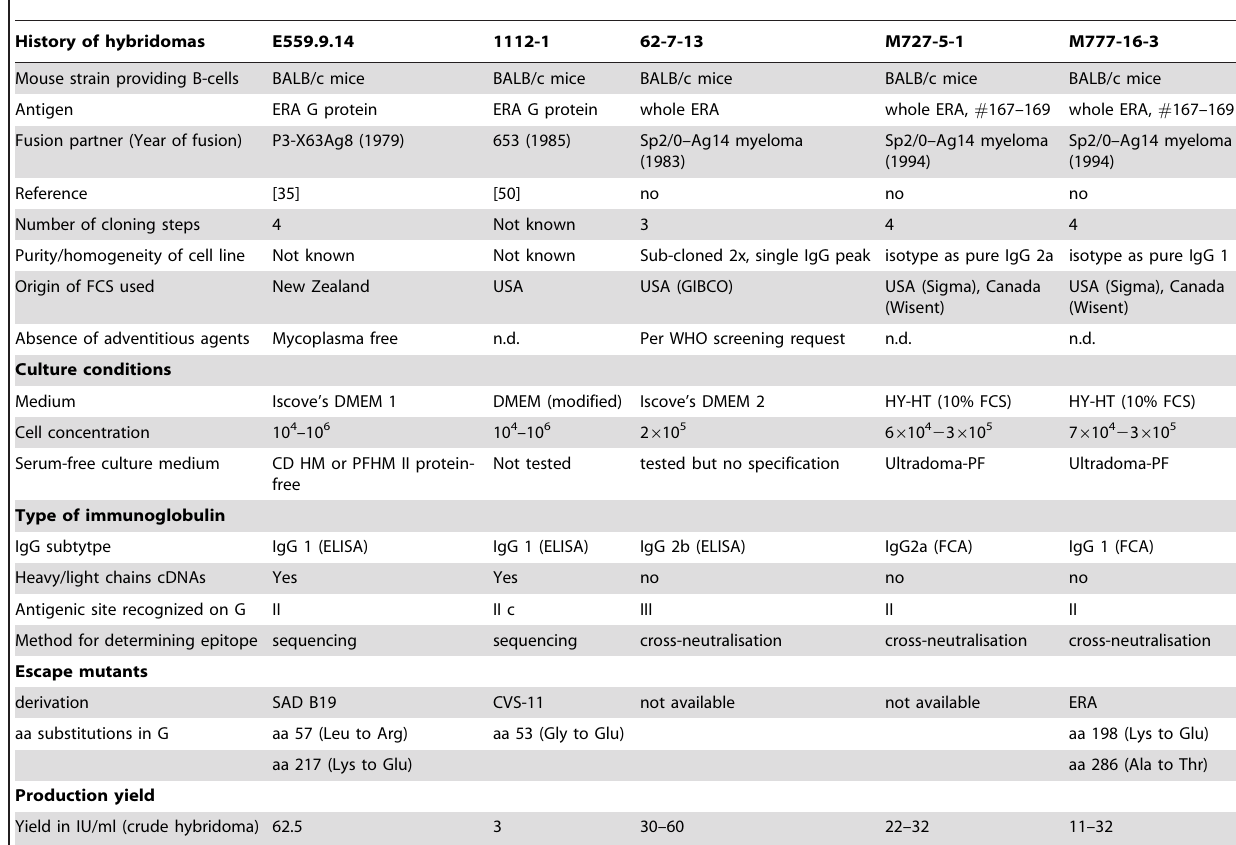
Table 1. Available technical information for candidate